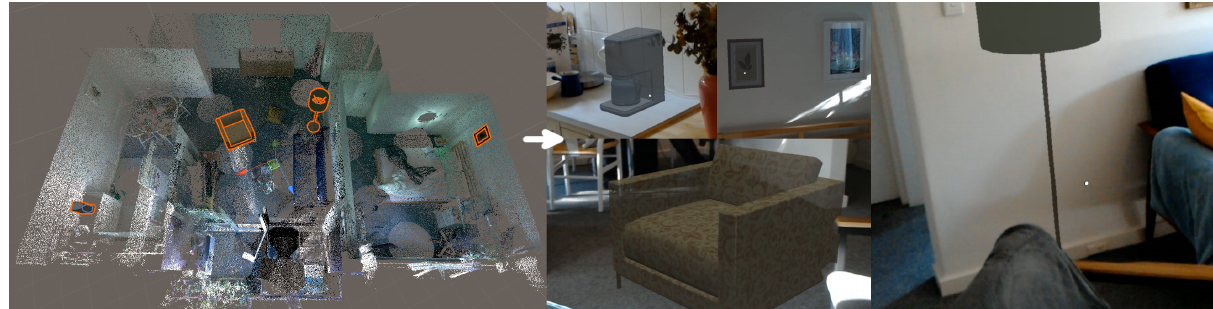
Figure 2. Anchoring of virtual objects, outlined in orange within the reference point cloud to the left, within the real world. Any number of virtual objects can be placed anywhere within the reference point cloud and they are anchored with high accuracy and without stuttering. The occlusion of objects needed for MR applications can be seen on the armchair and the lamp.